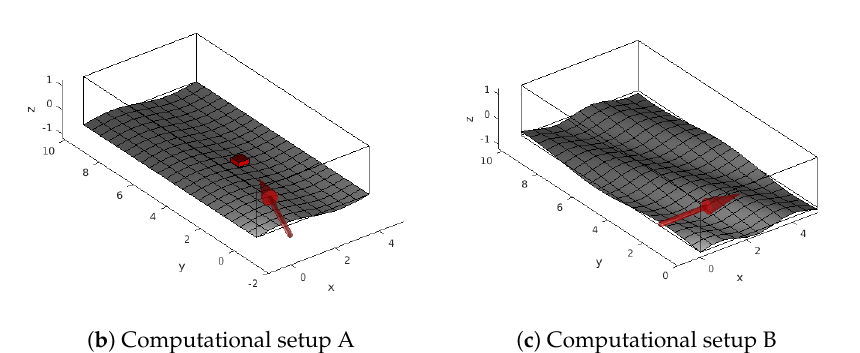
Figure 1. Computational domains considered for DNS simulation (upper walls not shown). ( a ) shows a generic flow configuration used in this work and in reference [3]. Most computations conducted considering a slanted inlet velocity profile ( b ) with θ = 70 ◦ ; one verification computation has been con- ducted on a slanted domain ( c ). Additionally, in ( b ), one of the spectral domains used for discretization is